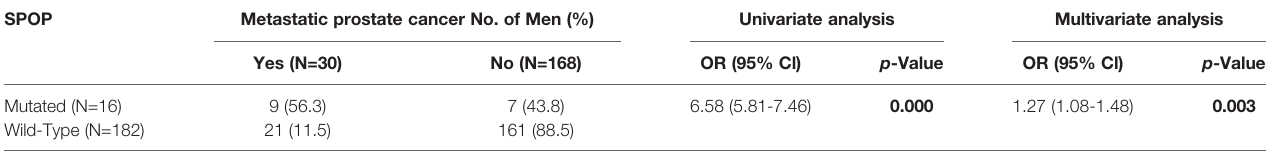
Bold values mean the p-values < 0.05.